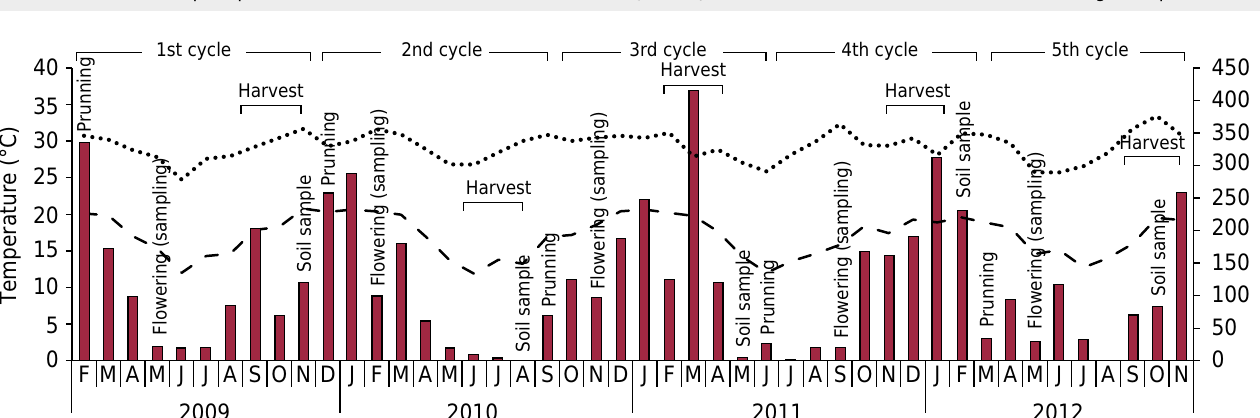
Accumulated precipitation